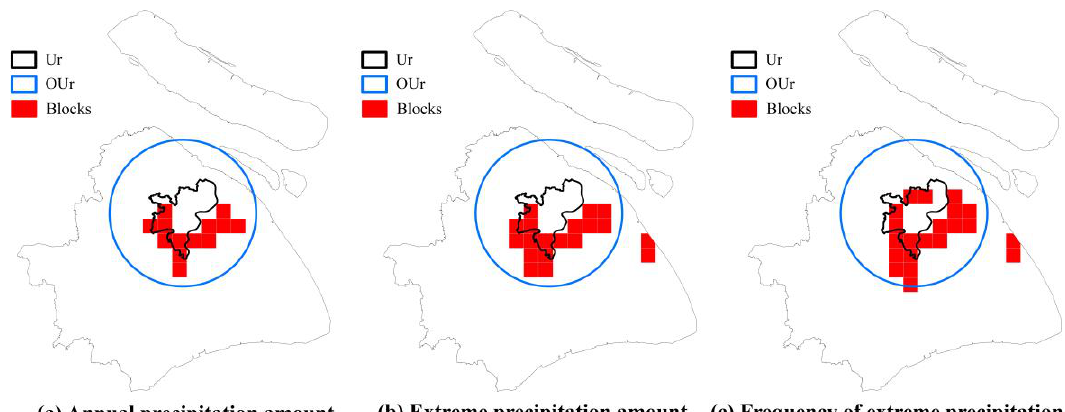
Figure 11. Spatial distributions of the grids with upward precipitation trends and rapid built-up area changes: ( a ) annual precipitation amount; ( b ) extreme precipitation amount; and ( c ) frequency of extreme precipitation.